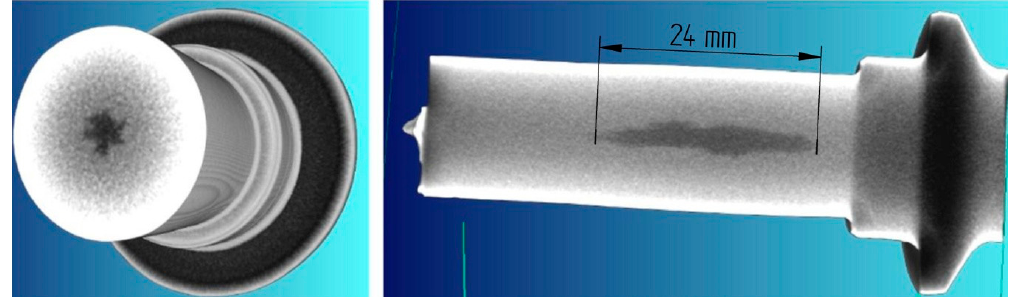
Figure 5. Preform of the harrow tooth obtained in the researched CWR process.